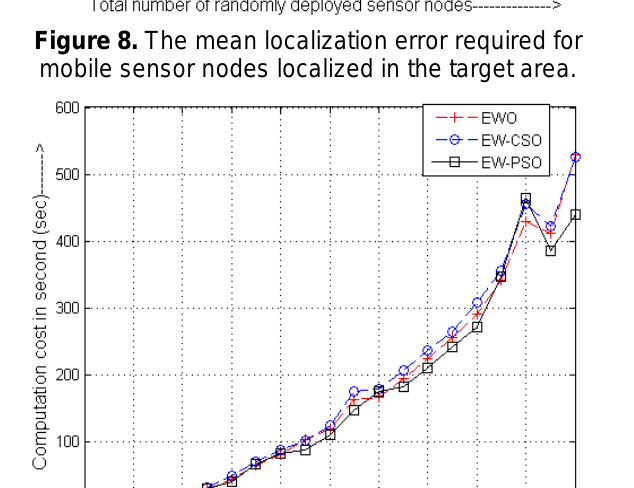
Figure 8. The mean localization error required for mobile sensor nodes localized in the target area.